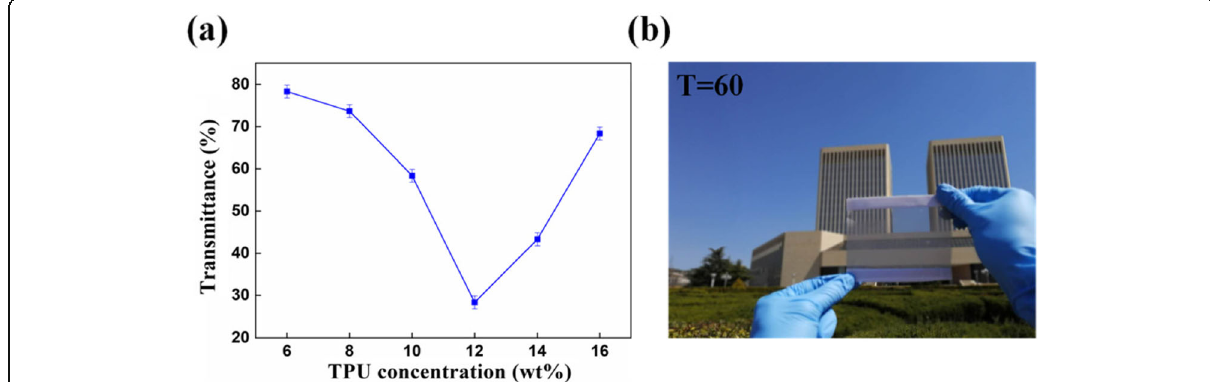
Fig. 7 Transmission properties of TPU fiber membrane. a Transmittance of different concentrations of TPU fiber membrane. b Photographs of TPU concentration of 10 wt% transparent air filters at 60%